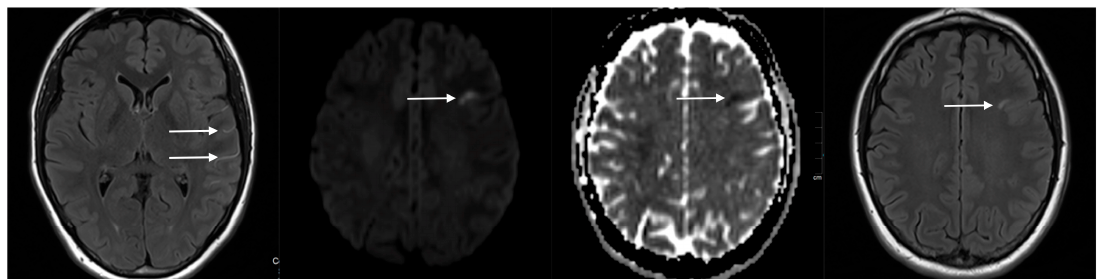
Figure 5. Representative magnetic resonance imaging (MRI) sections of the patient presenting with acute global aphasia three weeks after FDS implantation. From left to right: Fluid Attenuated Inversion Recovery (FLAIR) sequence reveals slow flow in the hyperintense M4 segments of the left hemisphere (white arrows). Diffusion weighted imaging (DWI) shows acute-stage subcortical infarction in the left-sided, frontal middle cerebral artery (MCA) territory. Corresponding FLAIR section confirms the subcortical infarction revealed by DWI.